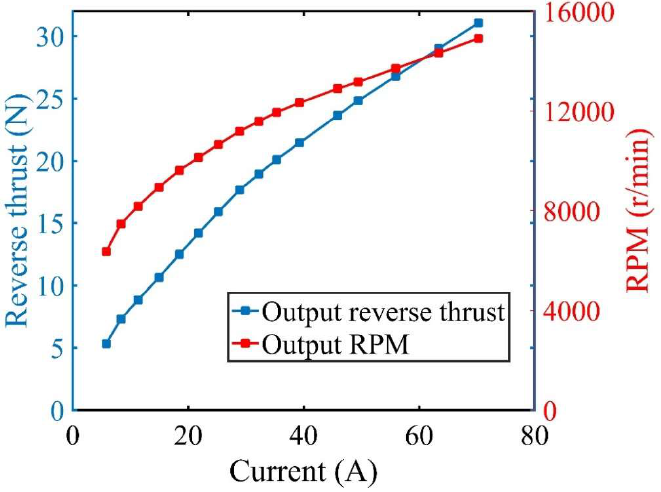
Figure 10. Aerodynamic characteristics of rotor unit.